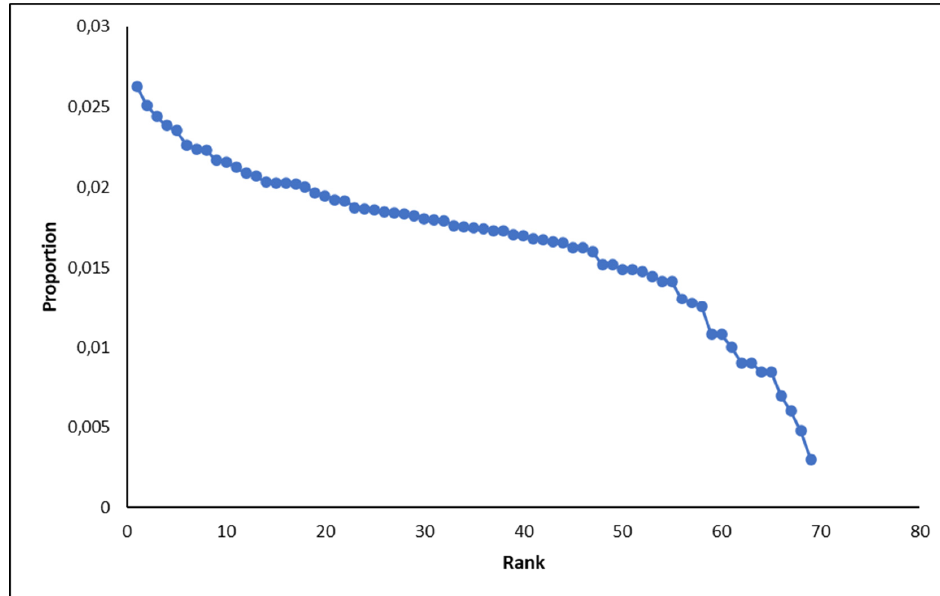
Figure 6A. Rank-abundance curve or Whittaker plot of butterfly community in the study